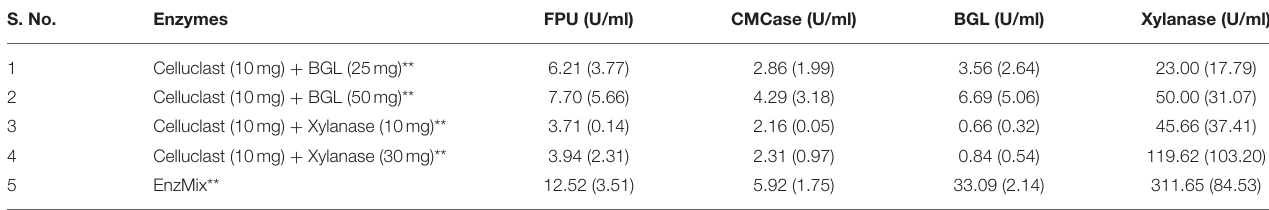
TABLE 2 | Synergism between Celluclast and accessory enzymes. S.